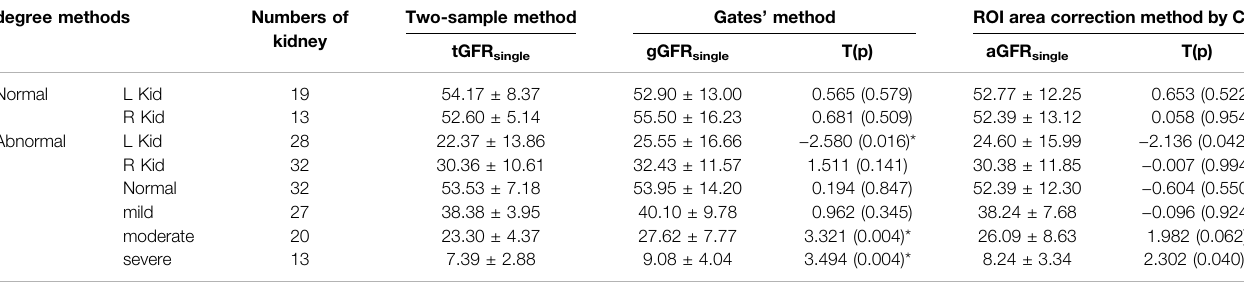
TABLE 1 | Glomerular fi ltration rate (GFR) measured by three methods in the patients with hydronephrosis. degree